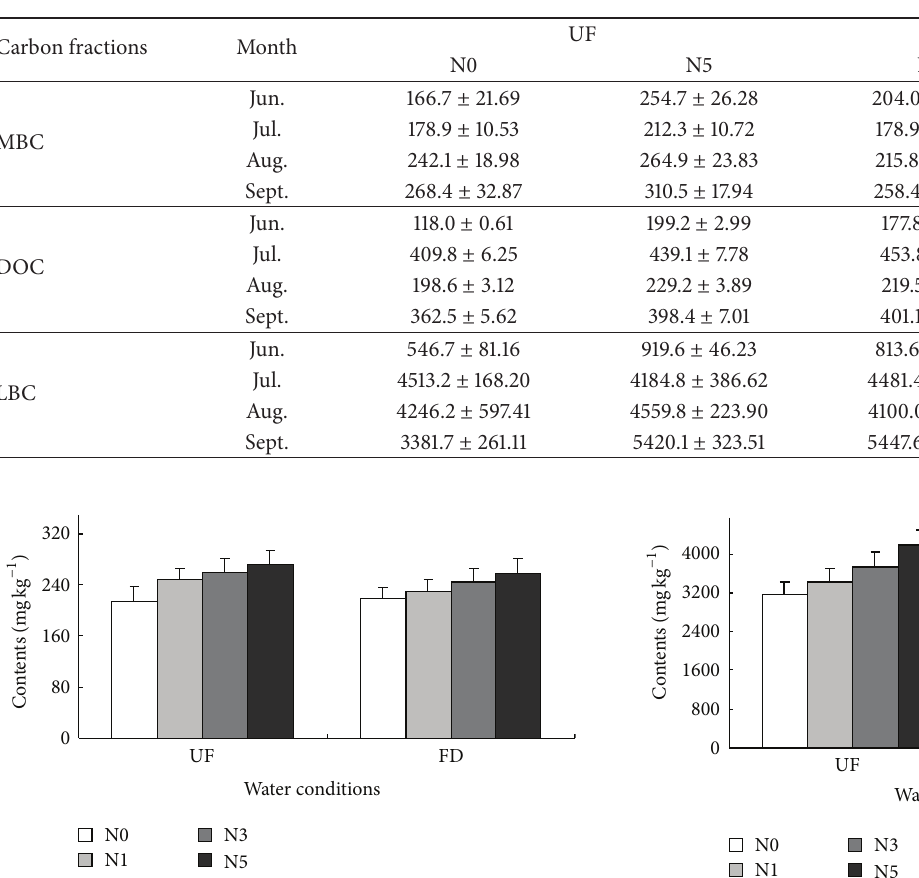
Table 2: The contents of wetland soil carbon fractions under N-deposition (mg ⋅ kg − 1 ).